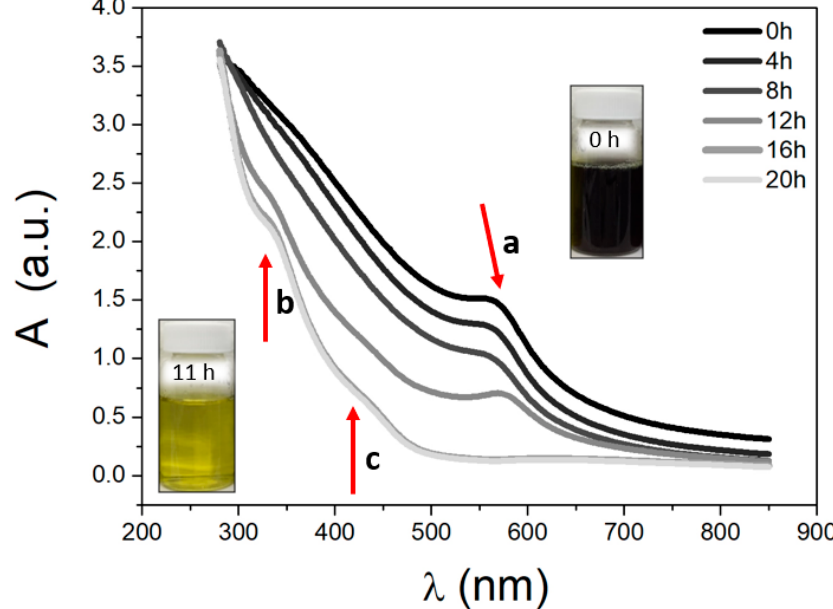
Figure 1. Evolution UV-Vis spectra of the colloidal suspensions recorded over 20 hr. Spectra were recorded at 20 °C between 300 and 850 nm, measured every 15 min. The insert shows a photograph of a glass vial that is similar to the colored colloidal suspension.